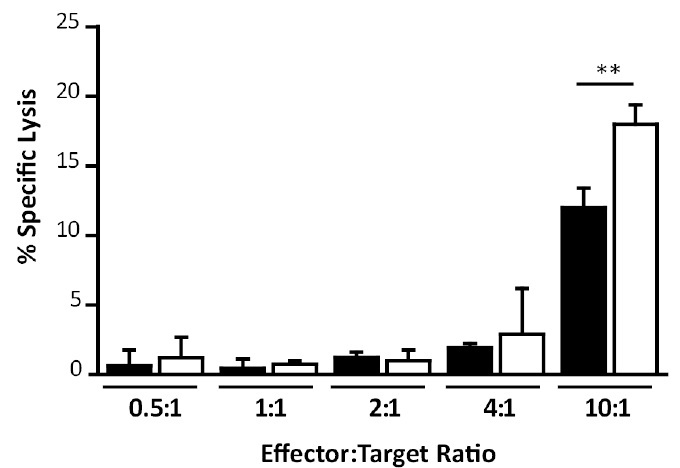
Figure 7. Study of in vitro T-cell specific killing activity. Specific cytotoxicity assay against B8R-pulsed cells was performed as described in Materials and Methods. Data are expressed as mean + SD of triplicate determinations and represent two independent experiments. Significant differences between MVAwt (black) and MVA ∆ C12L/ ∆ A44L-A46R (white) are shown. One-way ANOVA and Bonferroni’s post-test. ** p < 0.01.